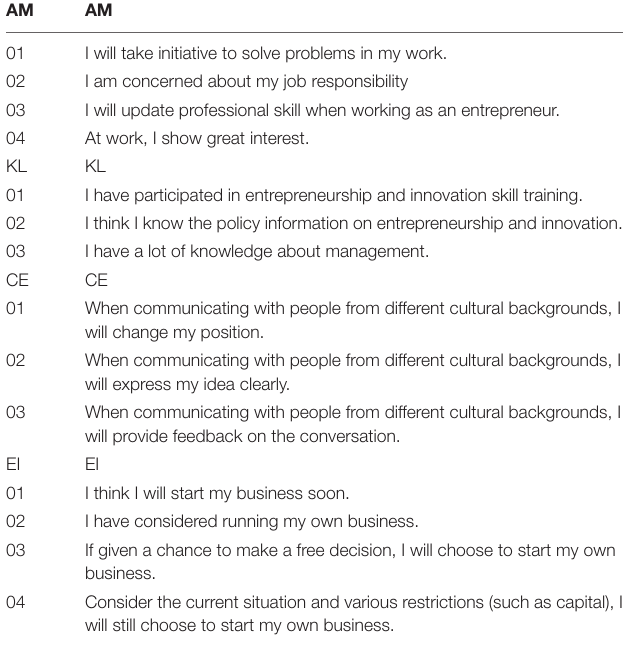
TABLE 1 | Part of the QS.